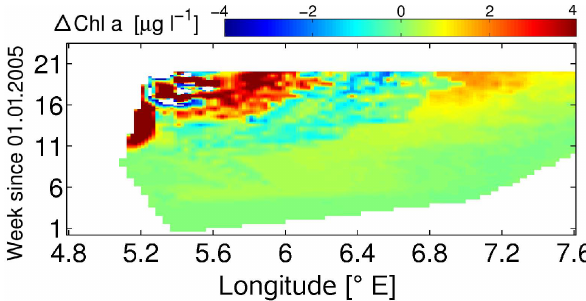
Fig. 9. Differences in CHL- a between the reference run in 2005 and the same run with 2004 hydrodynamics. Deviations are only attributable to differences in the current